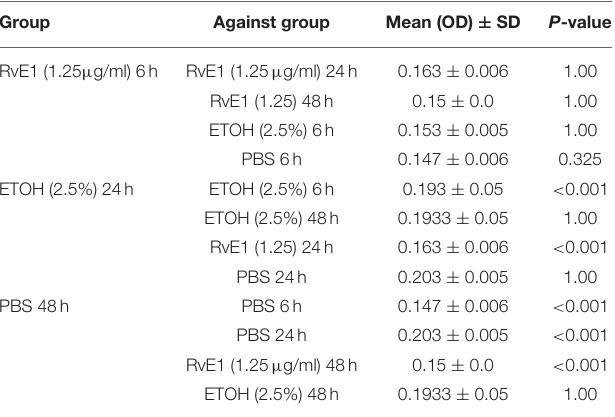
TABLE 2 | Comparisons of specific concentrations at different time points (6, 24, and